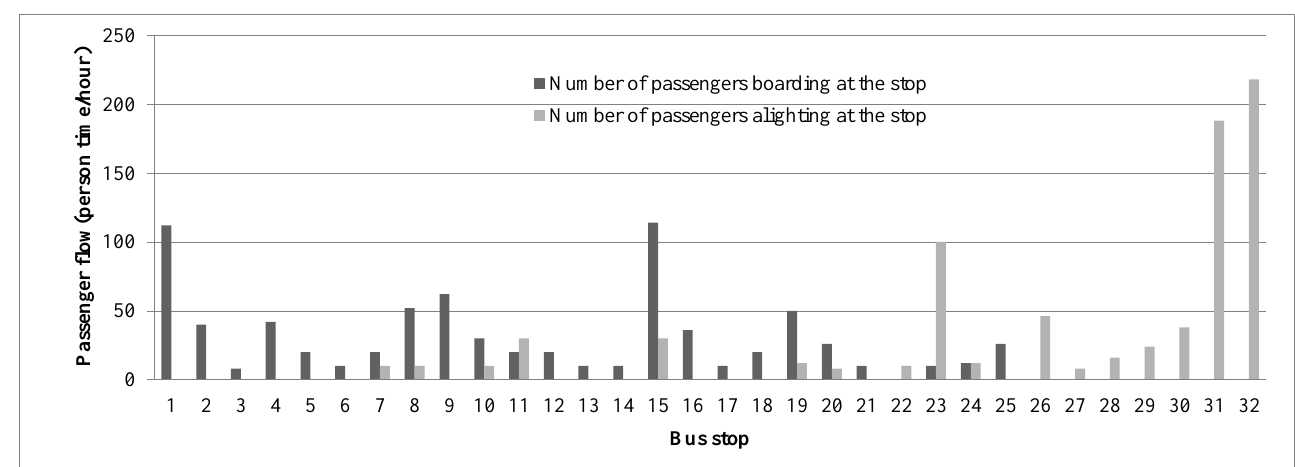
Figure 2. Passengers demand of boarding/alighting at the stop from Zhenjiang to Rongbing during the morning peak (7:00 a.m.~ 8:00 a.m.).